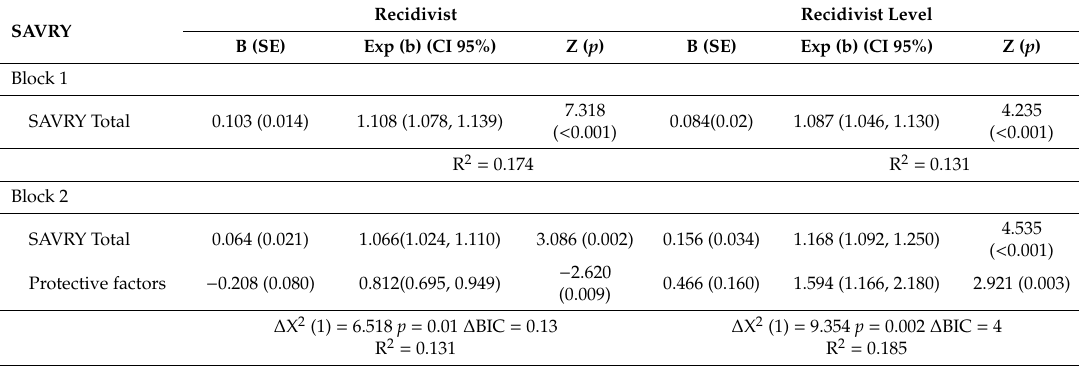
Table 4. Incremental validity of protective factors (logistic regression).